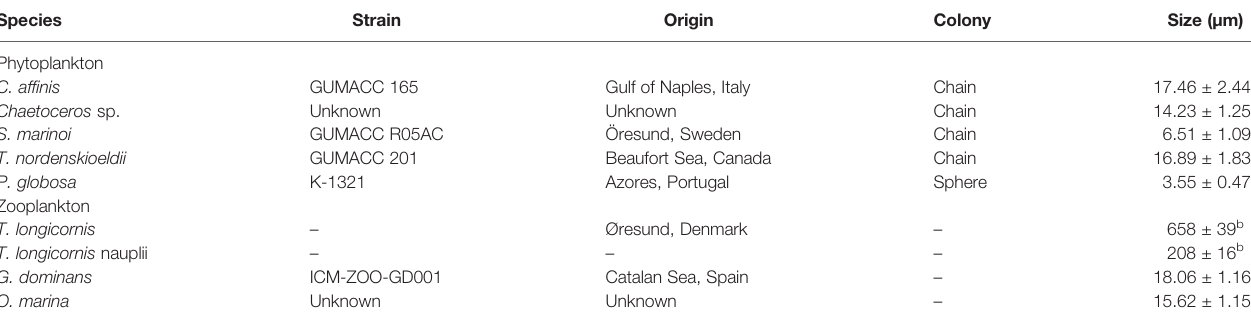
Equivalent spherical diameters (ESD) for phytoplankton were based on measurements of 20 individual cells under the inverted microscope after assigning fi tting geometric shapes (Hillebrand et al., 1999). Spines were not included for the Chaetoceros spp. and T. nordenskioeldii measurements. Prosome length for copepods were measured in ImageJ or under the inverted microscope. ESD for G. dominans and O. marina were measured in a Multisizer 4e Coulter Counter. The phytoplankton cultures were obtained from the Gothenburg University Algal Bank(GUMACC), The Norwegian CultureCollectionof Algae (NORCAA) orfrom a culture atDTUAqua (Chaetoceros sp.).Sizes arepresented as means± standard deviation. Dash indicates data unavailable or not applicable. a ESD, b prosome